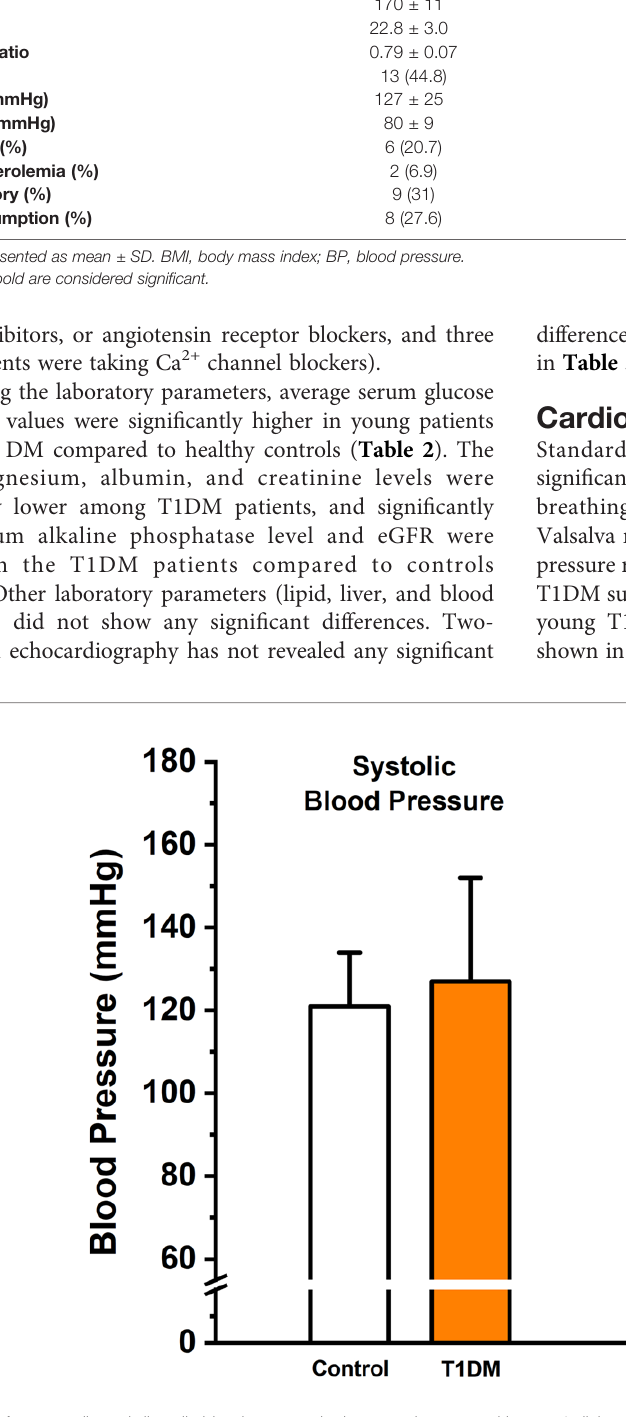
FIGURE 1 | Mean systolic and diastolic blood pressure in the control group and in type 1 diabetes mellitus (T1DM) patients; **p<0.01 vs. control group; n=30 and 29 individuals in the control and T1DM groups, respectively.